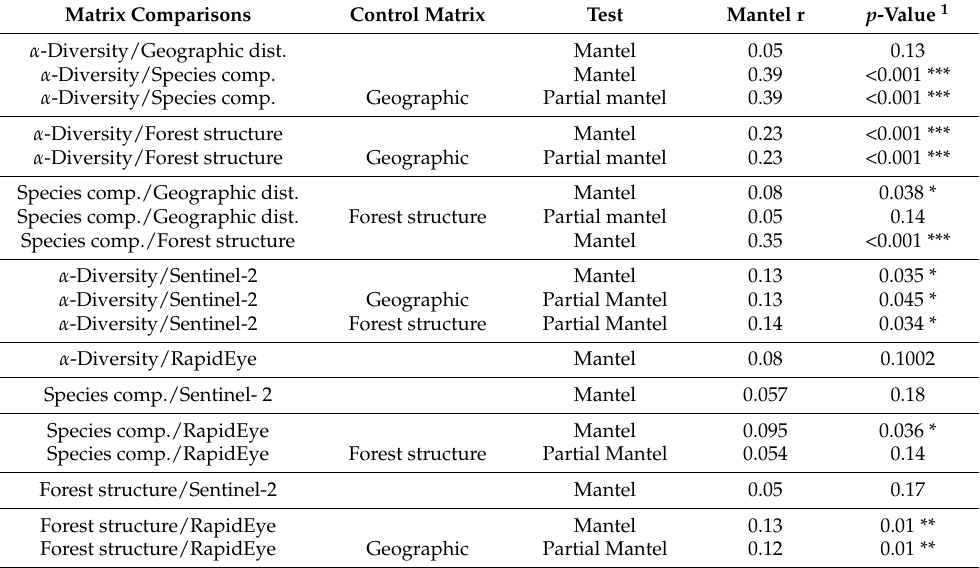
Table 6. Mantel and partial mantel test comparing Sentinel-2 and RapidEye spectral data and indices from 0.10 ha randomly spaced training data samples ( n = 55) with forest composition, structure, and α -diversity values. The Bray–Curtis distance was used in all cases with the exception of geographic distance measured from plot coordinates that used Euclidean distance. Matrix Comparisons Control Matrix Test Mantel r p -Value 1 α -Diversity/Geographic dist.